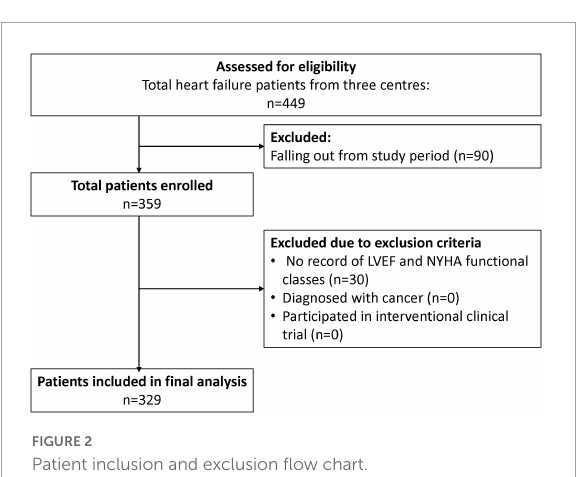
FIGURE2 Patient inclusion and exclusion flow